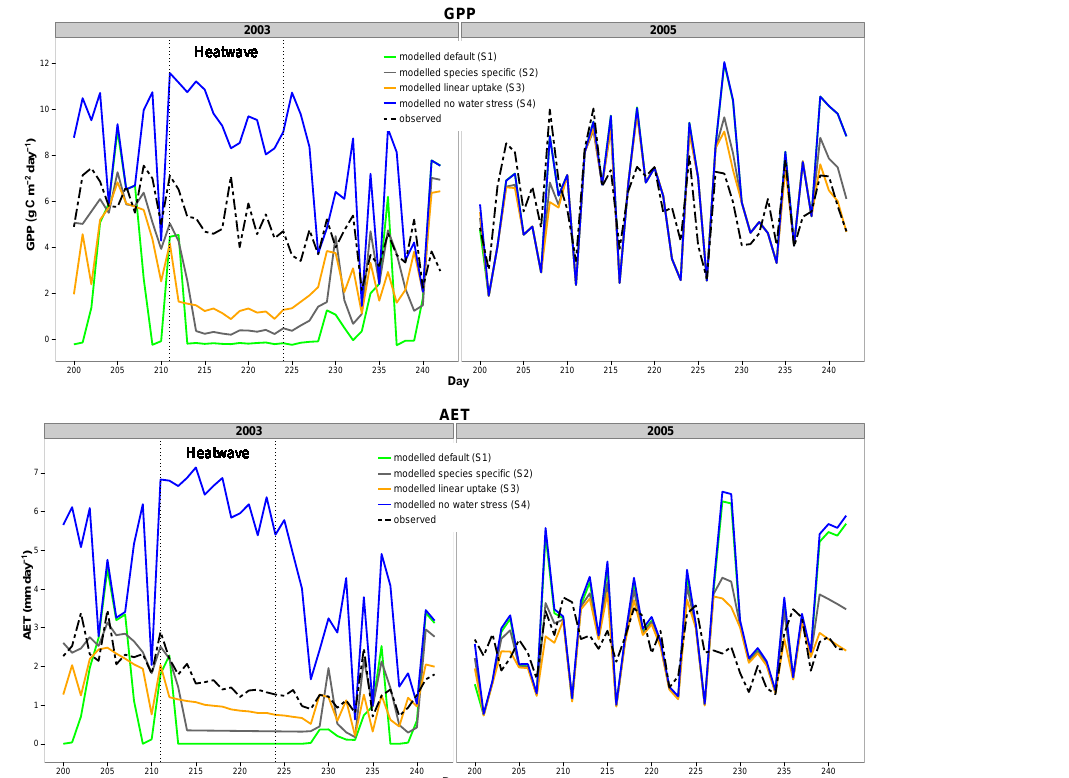
Figure 10. Daily observed and modelled fluxes for (a) GPP (gCday − 1 ) and (b) AET (mmday − 1 ) for July and August in two different climate years. In summer 2003, a heatwave and corresponding drought occurred in Europe (e.g. see Teuling et al., 2010). Based on long- term averages of the Dutch Royal Meteorological Institute (KNMI), higher temperatures, more sunshine hours, and much less precipitation occurred during this summer, and an official heatwave took place in the Netherlands during August (KNMI, 2003). The KNMI defines a heatwave as a period of at least 5 consecutive days in which the maximum temperature exceeds 25 ◦ C, provided that on at least 3 days in this period the maximum temperature exceeds 30 ◦ C. Based on these criteria, the heatwave duration was from 31 July to 13 August and is marked in the graph by two dotted black vertical lines. The summer of 2005 had average temperatures and sunshine but was much wetter, and August was a month with particularly high precipitation compared to long-term averages (KNMI,